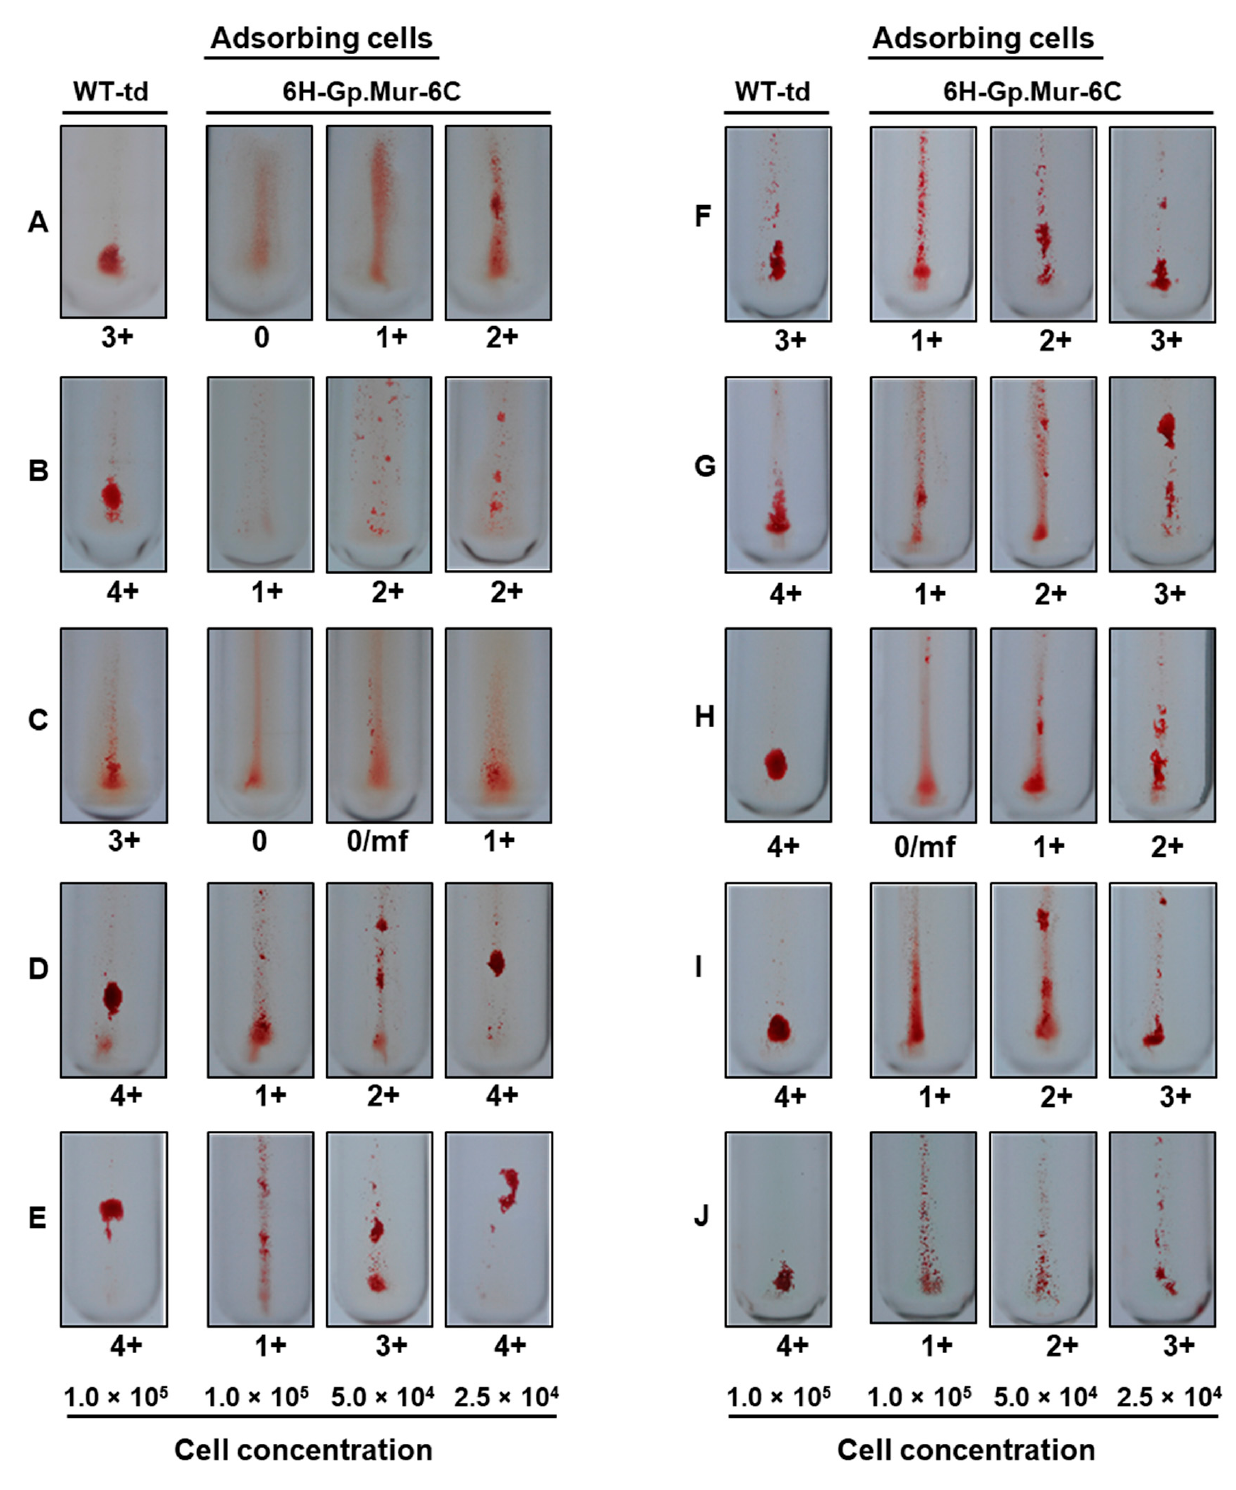
Figure 3. Hemagglutination inhibition based on the conventional tube method. A total of 10 serum samples ( A – J ) were treated with varying concentrations of Hi5 cells expressing Gp.Mur antigen (1.0 × 10 5 , 5.0 × 10 4 , or 2.5 × 10 4 ). As a control, we used WT-td-infected Hi5 cells (1.0 × 10 5 ). Evaluation of levels of hemagglutination revealed a dose-dependent hemagglutination inhibitory response due to anti-Gp.Mur antibody in the sera. Samples ( A – I ) were tested at the IS phase, whereas sample ( J ) was tested at the AHG phase. The 0/mf indicates presence of small agglutinates among nonagglutinated